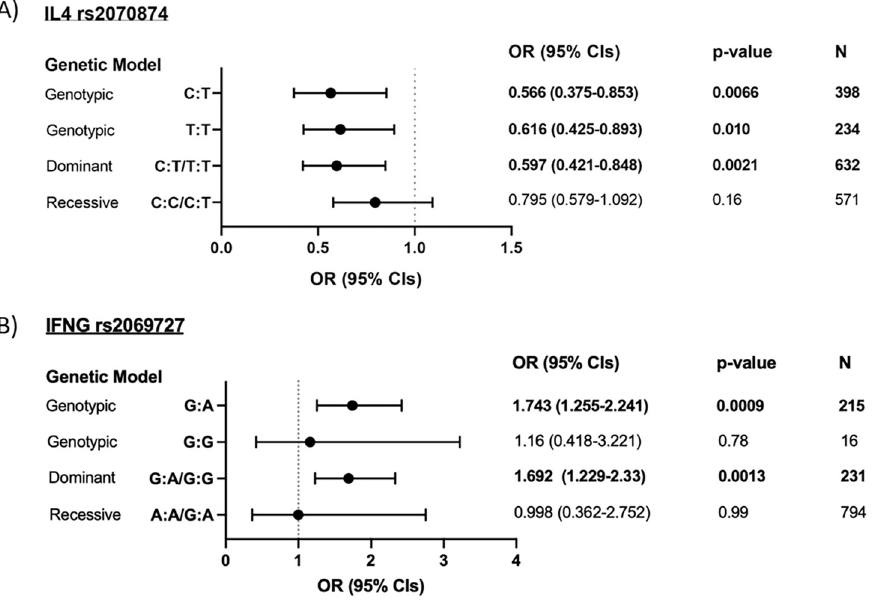
Fig 3. A) Odds ratios of S. haematobium infection between genotypes of SNPs IL4 rs2070874 (N = 805) and B) IFNG rs2069727 (N = 810). Models are adjusted for the confounding variables of participant age, sex and village. These data indicate that the C:T and T:T genotypes and the T allele of IL4 rs2070874 was associated with protection from S. haematobium infection, and that the G:A genotype and the G allele of IFNG rs2069727 was associated with elevated risk of infection with S. haematobium. OR = odds ratio; CIs = confidence intervals. Genotypic and dominant models display ORs relative to the homozygous reference genotype; recessive models display ORs relative to the homozygous variant